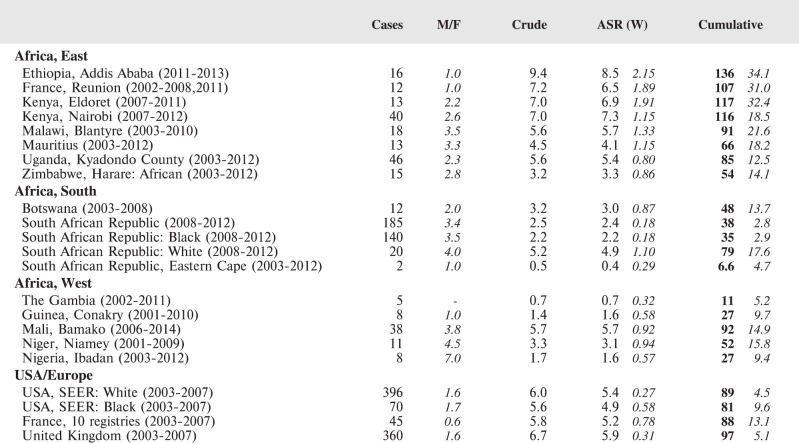
Crude, age-standardised (world), and cumulative (0–14) incidence rate (per million) and standard errors – Hodgkinlymphoma.